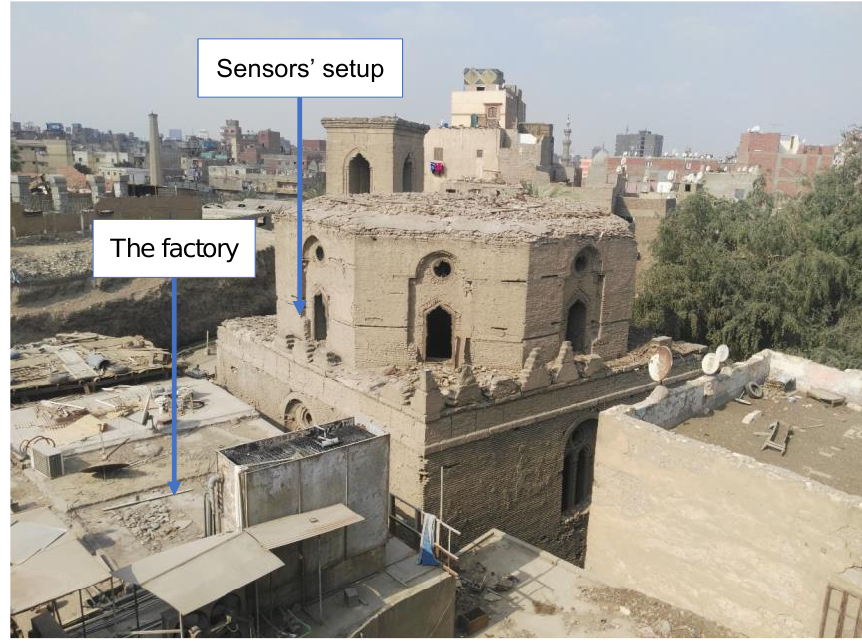
Figure 11. Location of the ice-cream factory relative to the dome (looking north).